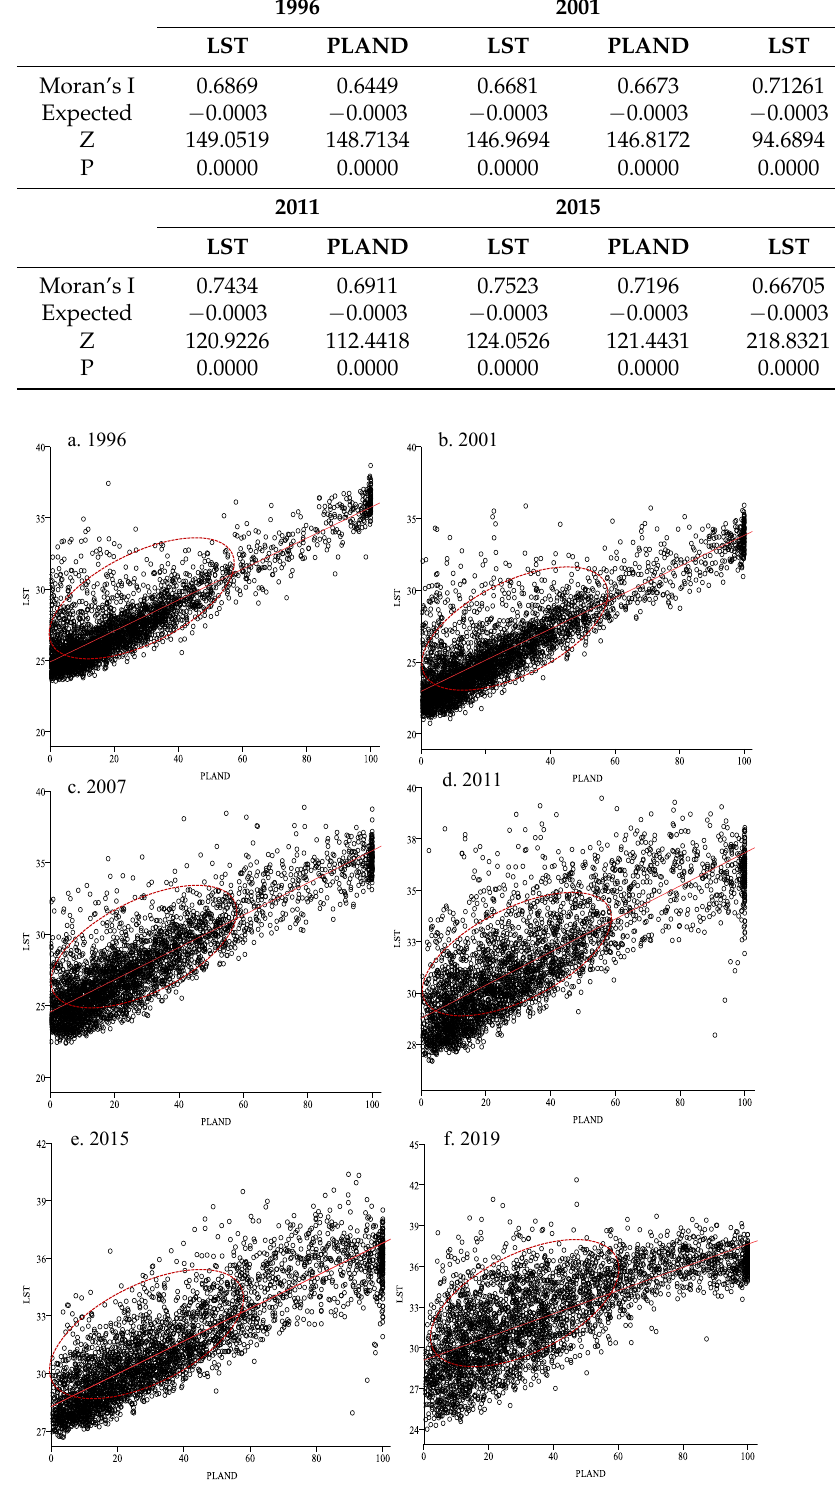
Figure 10. Correlation analysis results of the percentage of built-up land (PLAND) and land surface temperature (LST) from 1996 to 2019.